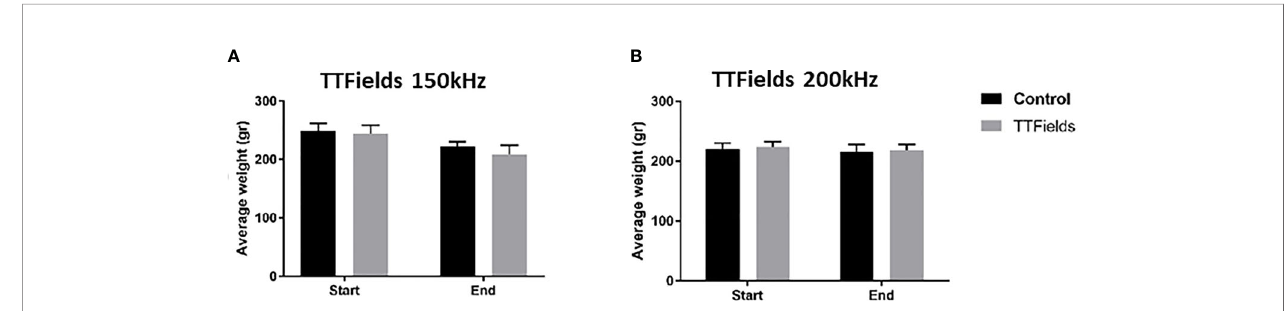
FIGURE 2 | Animal weight at the beginning and end of 2 weeks of sham or TTFields application. Average weights ± standard deviations at study start and end are shown for control animals versus animals treated with TTFields at frequencies of 150 kHz (A) or 200 kHz (B) . TTFields vs control non-signi fi cant; Student ’ s